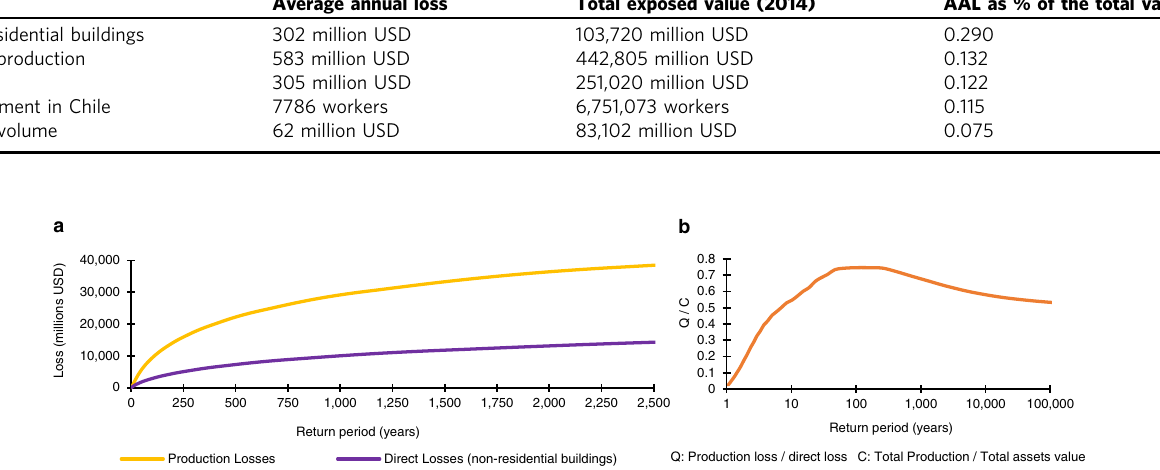
Fig. 1 Loss Exceedance Curves (LECs) of direct and production losses. We are representing the LEC with the return period (the inverse of the exceedance rate) in the horizontal axis and the loss values in the vertical axis. a Shows the LECs expressed in million dollars. Direct losses refer exclusively to non- residential buildings of the country. b Shows the relation between production losses and direct losses, Q , as a function of the return period. The ratios are presented normalized to C , being C the ratio between total production and the total value of assets (non-residential buildings).